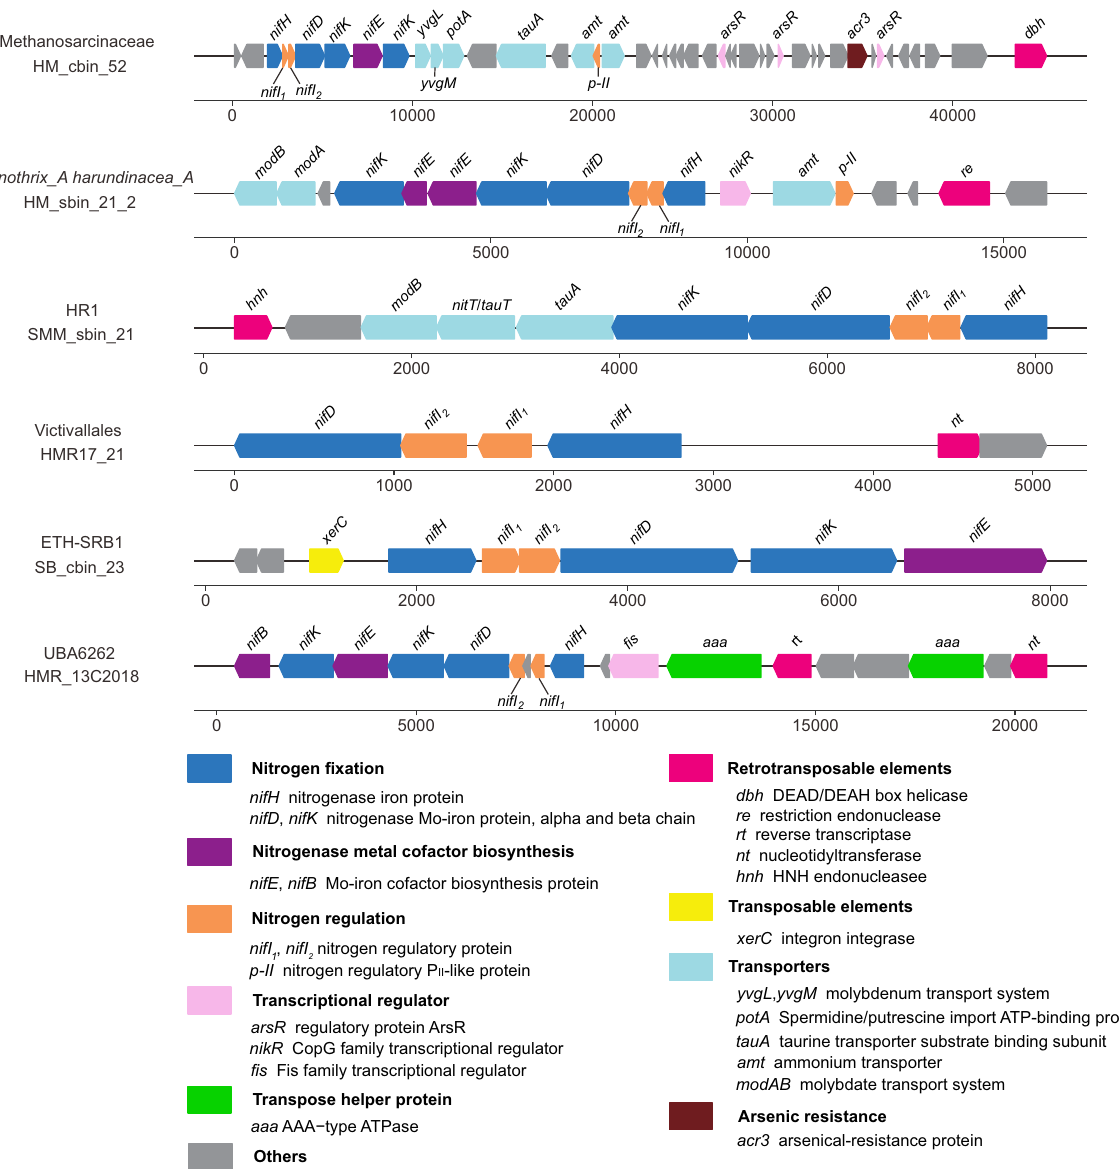
Fig. 6 | Genomic context of nitrogen fi xation genes. Gene neighborhoods of nifHDK include retrotransposable or transposon elements, regulatory nitrogen fi xation genes, nitrogenase metal cofactor biosynthesis genes and transporter genes. Source data are provided as a Source Data fi